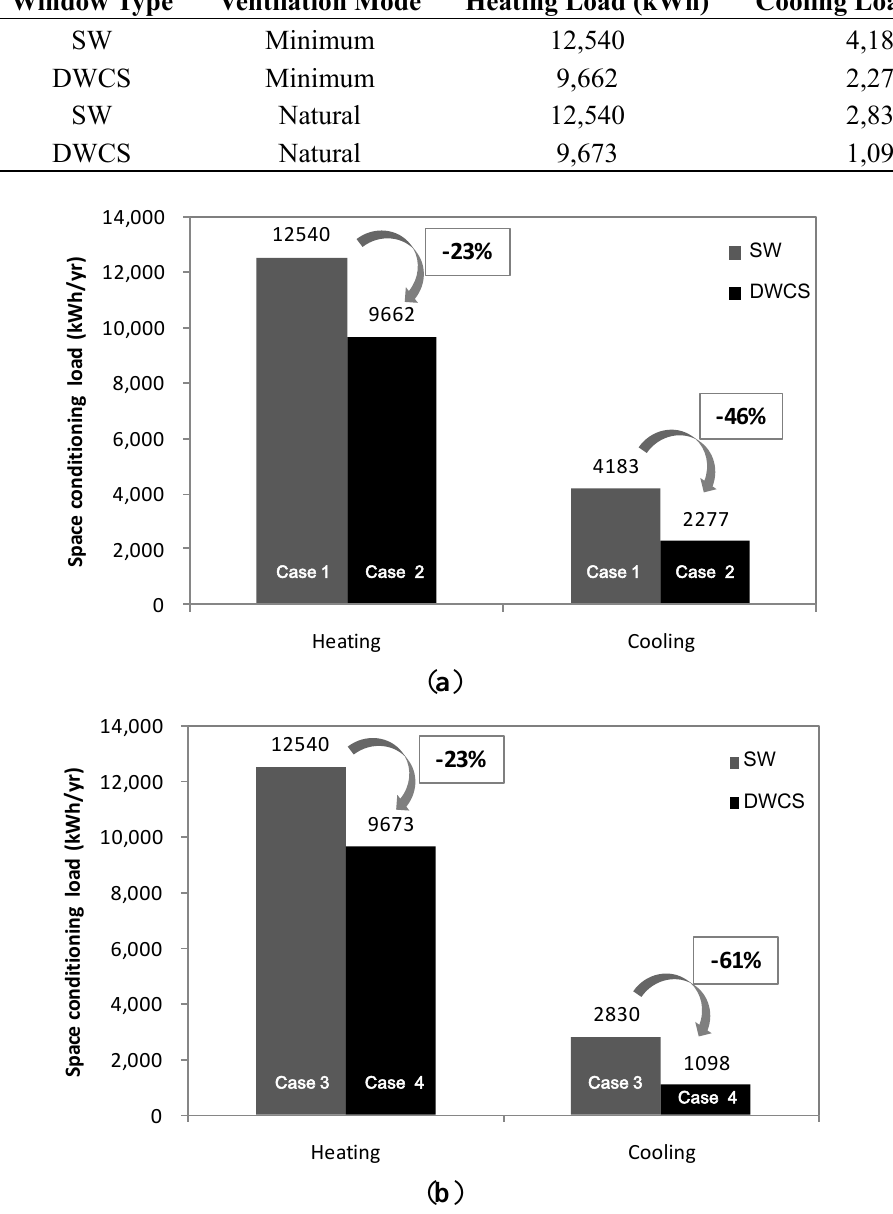
Figure 9. Space conditioning load reduction: ( a ) minimum ventilation conditions and ( b ) natural ventilation